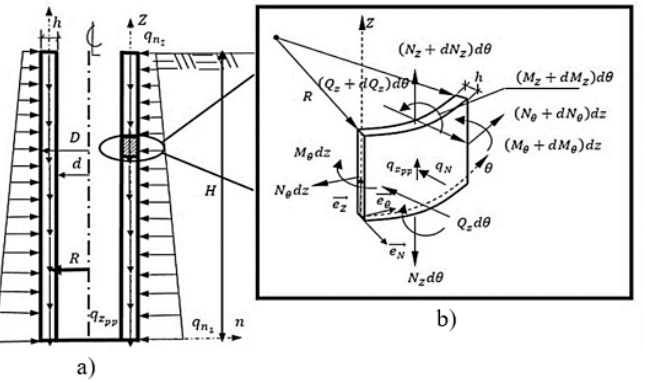
Figure 1. Mechanical model of tunnel ventilation shafts building by “floating shafts” construction system, ( a ) Analysis scheme for shafts, ( b ) Free body diagram of shaft differential slice (cid:1858)((cid:2009) ) ∈ ℝ (cid:2871) (cid:4579)(cid:4583)(cid:4583)(cid:4583)(cid:4583)(cid:4583)(cid:4580)(cid:4583)(cid:4583)(cid:4583)(cid:4583)(cid:4583)(cid:4581) , (cid:2009) , (cid:2009) (cid:2869) (cid:2870) (cid:2871)